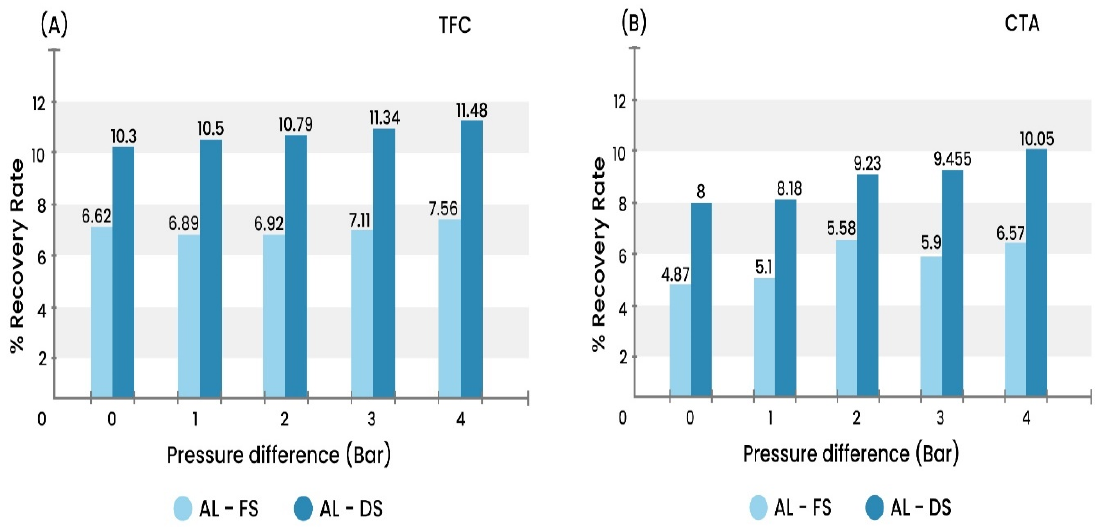
Figure 9. Recovery rate (%) of FO process at different applied pressures, using TFC membrane ( A ) and CTA membrane ( B ), in AL-FS and AL-DS orientations.